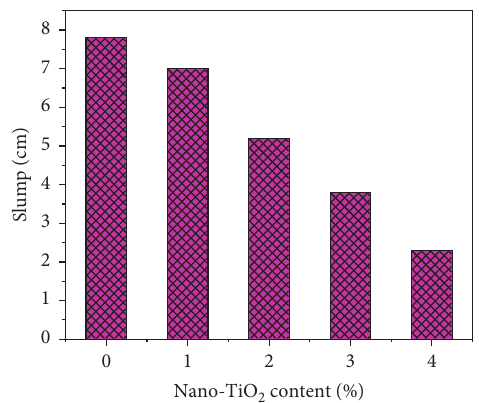
Figure 8: Effects of TiO 2 nanoparticles on the workability of concrete